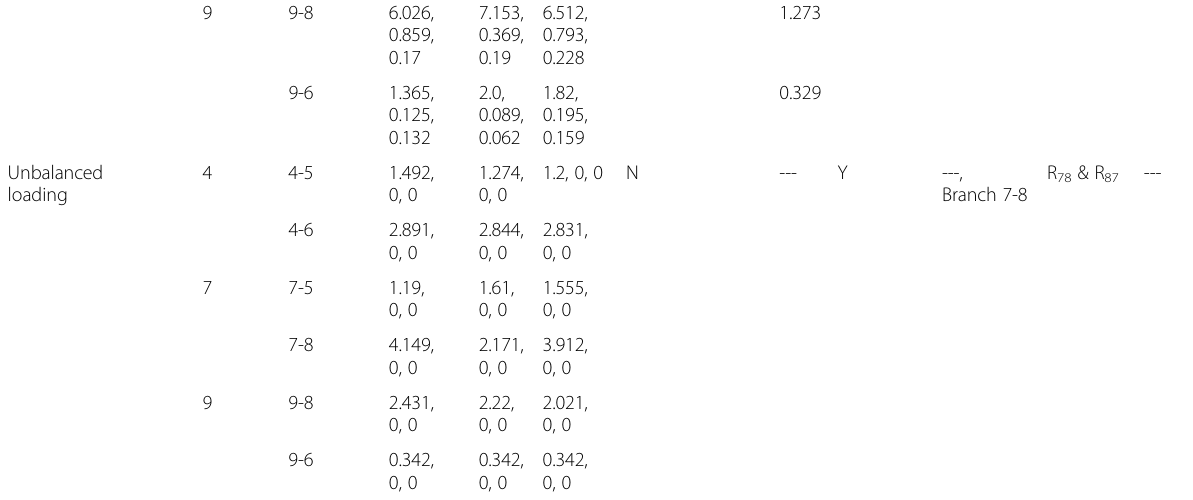
Table 2 Results of case studies, power system contingencies without and with fault conditions, conducted on WSCC-9 bus system